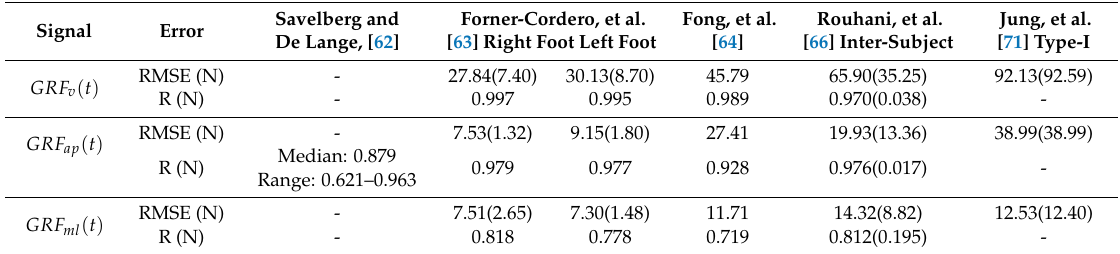
Table 2. Comparison of the RMSE mean (standard deviation) and cross-correlation coefficient of the methods suggested by Savelberg and De Lange [62], Forner-Cordero, et al. [63], Fong, et al. [64], Rouhani, et al. [66] and Jung, et al. [71]. Savelberg and Forner-Cordero, et al. Fong, et al. Rouhani, et al. Jung, et al. Signal Error De Lange, [62] [63] Right Foot Left Foot [64] [66] Inter-Subject [71]